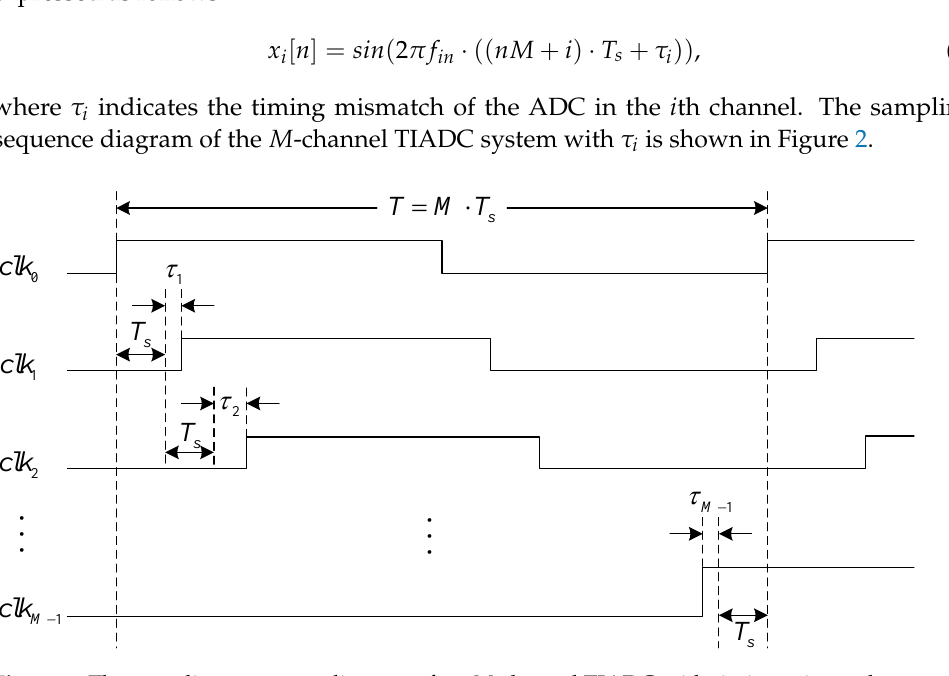
Figure 2. The sampling sequence diagram of an M -channel TIADC with timing mismatch τ i